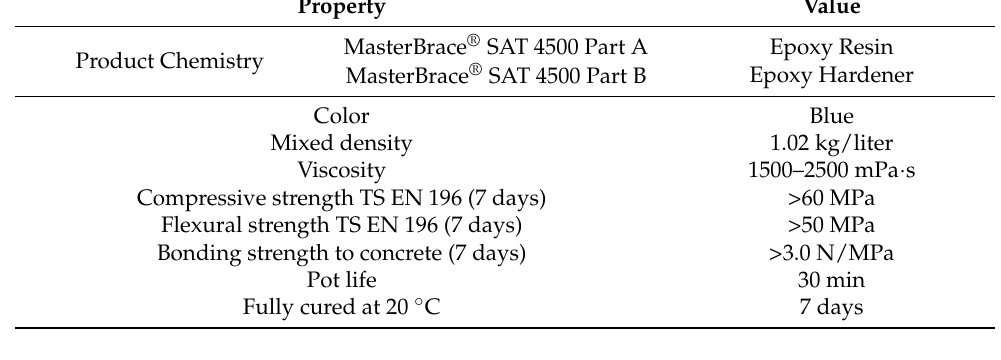
Table 5. MasterBrace ADH 2200 properties.